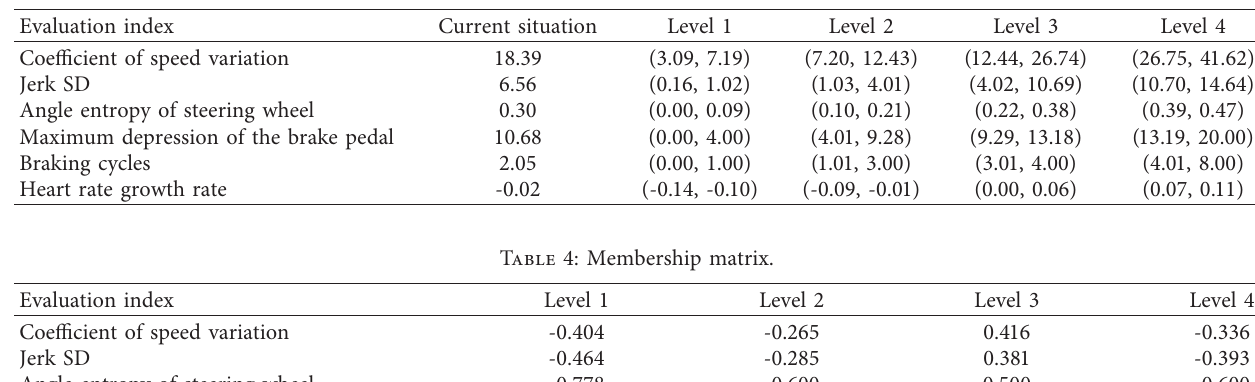
Table 3: Range of evaluation indexes.